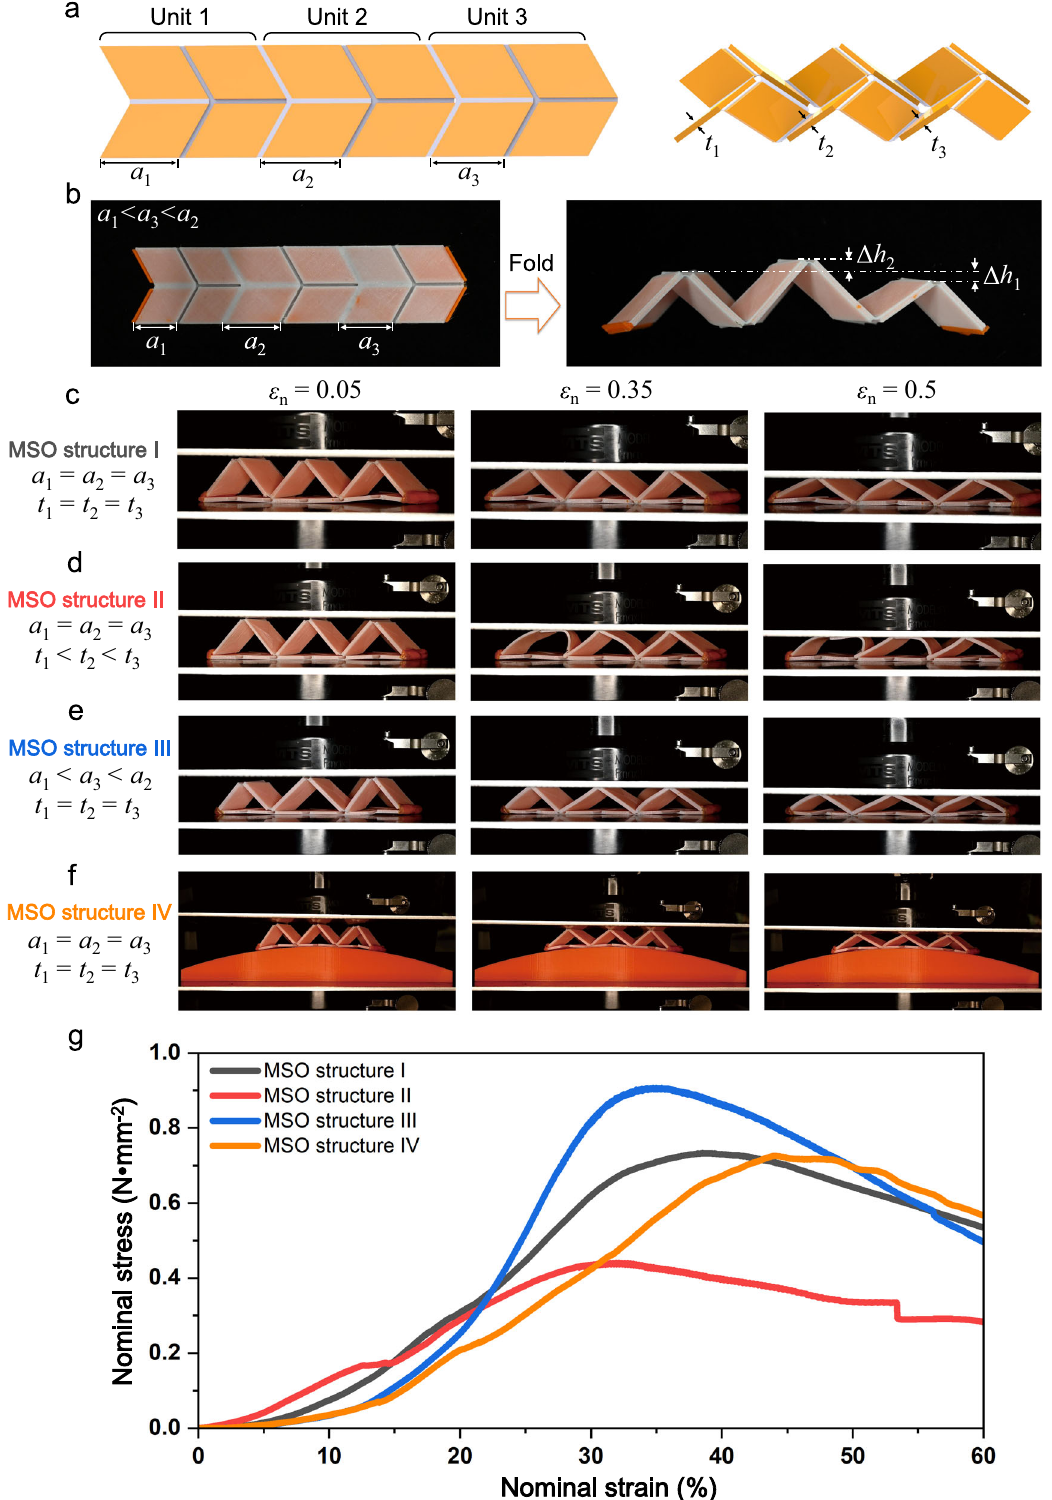
c – f Snapshots of MSO structure I-IV under compression. g Nominal stress – strain behaviors of four different MSO